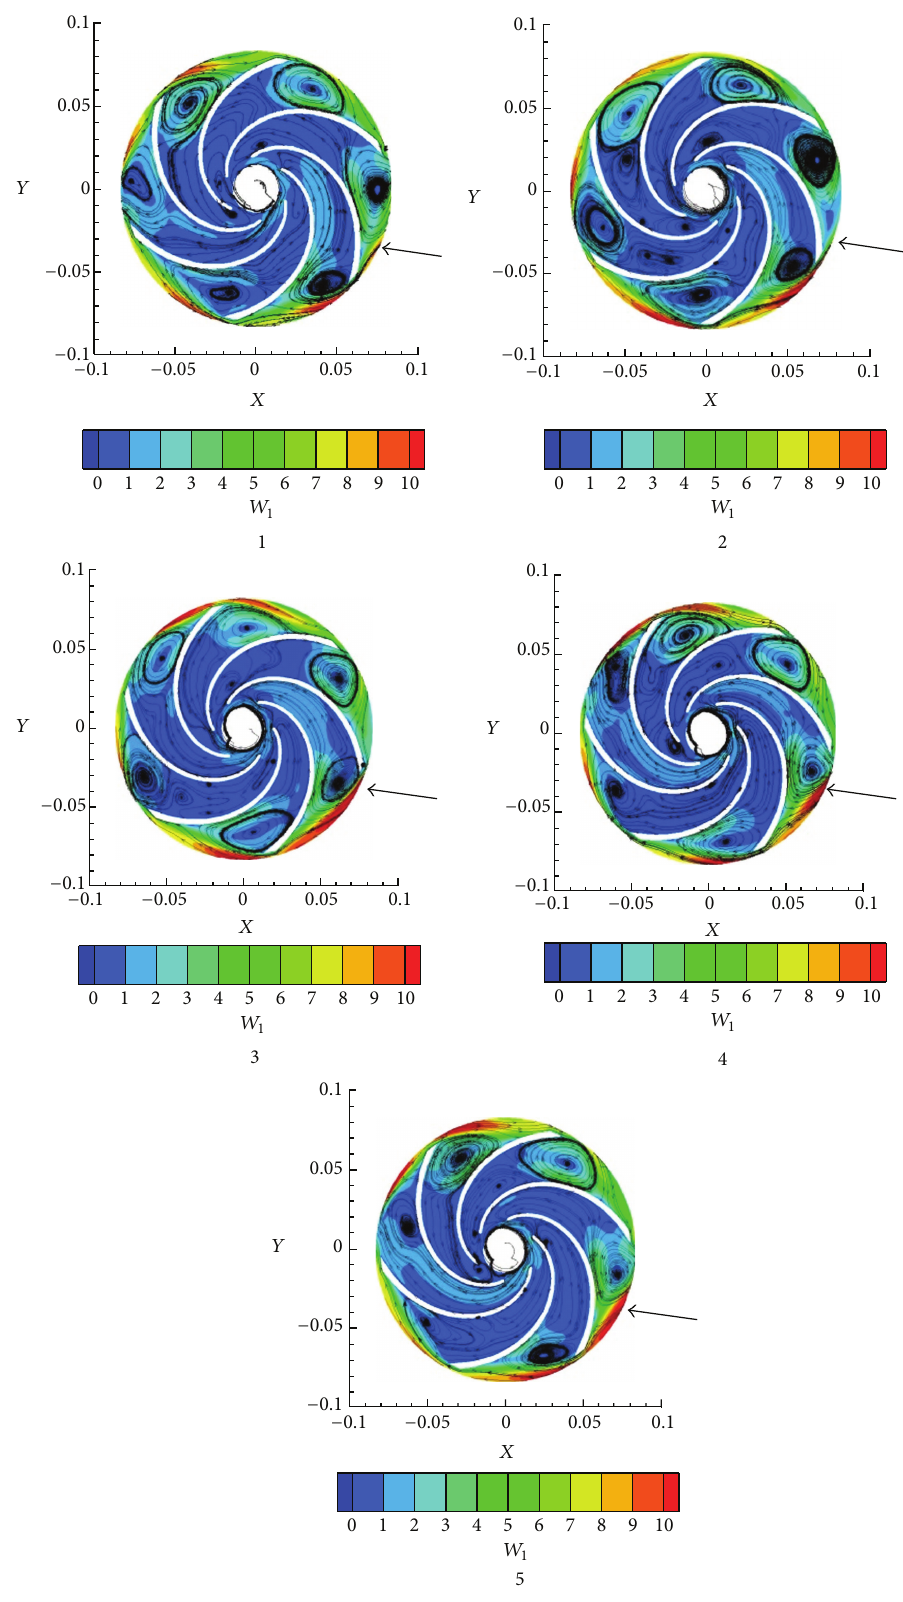
Figure 13: Relative velocity and its visualization at different positions with position of